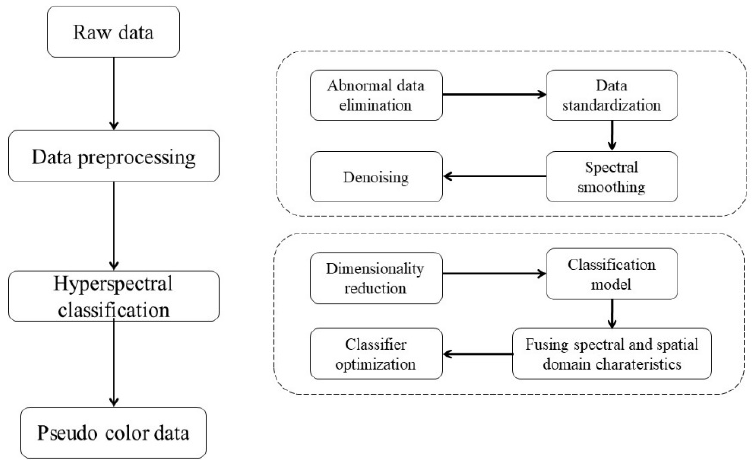
Fig. 2 Chart of hyperspectral data processing